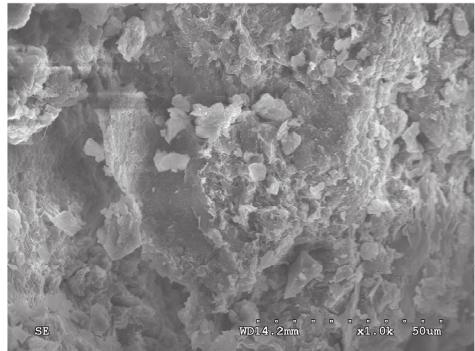
Figure 9: The soil of curing 14d and being magnified 1000 times.